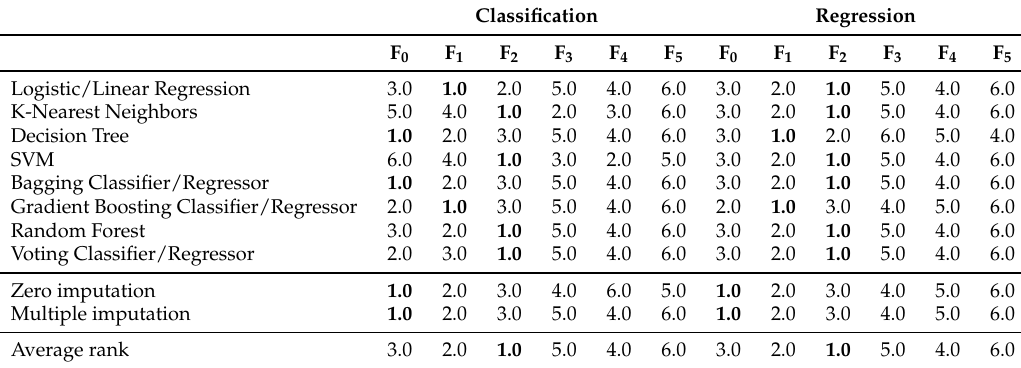
Table 7. Rankings of feature sets for different classification and regression models for sugar.